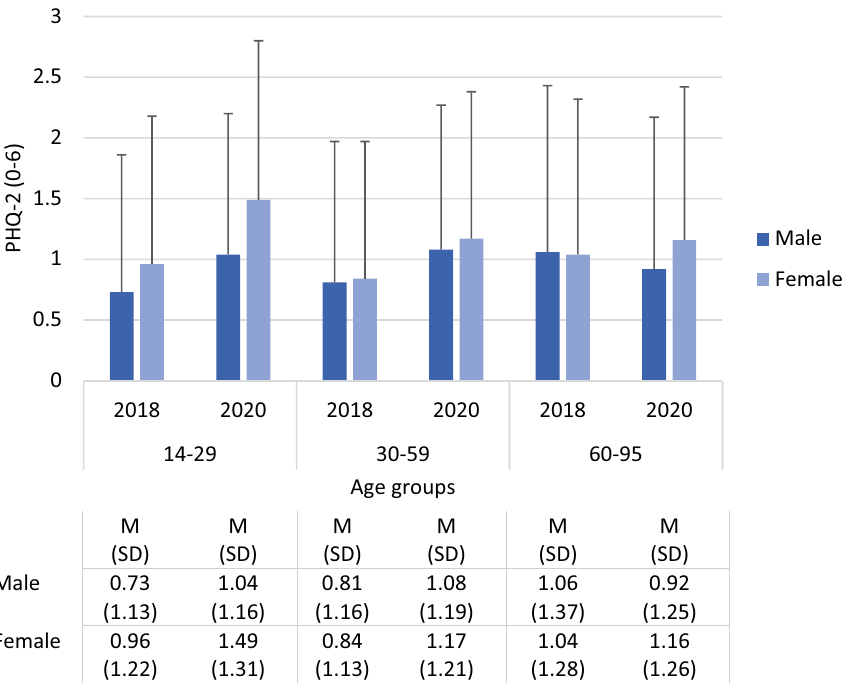
Figure 1. Depression scores in 2018 and 2020 by age group and sex. Analysis of variance: Survey (2018, 2020) by sex (male, female) by age group (14–29, 30–59, 60–95); F survey (df = 1) = 52.18, p < .001; F Sex (df = 1) = 14.36, p < .001; F age group (df = 2) = 3.31, p = .037; F survey by sex (df = 1) = 4.61, p = .03; F survey by age group (df = 2) = 15.11, p < .001; F sex by age group (df = 2) = 5.13, p =